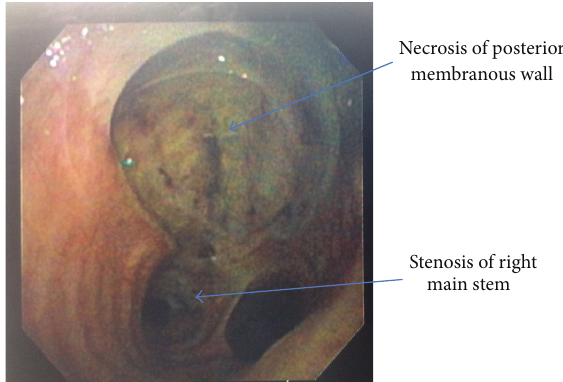
Figure 3: Bronchoscopy image showing necrosis of posterior membranous wall just above main stem